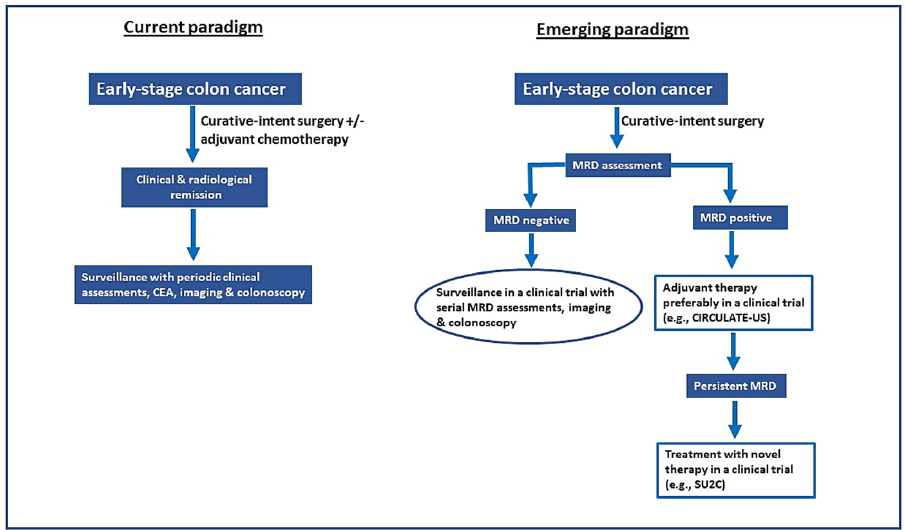
Figure 2. Comparison of current versus the evolving ctDNA-guided adjuvant therapy paradigm in patients with colorectal cancer treated with curative-intent surgery. However, the ctDNA-guided adjuvant therapy strategy needs confirmation through prospective clinical trials before wide adoption in routine clinical practice. CEA, carcinoembryonic antigen; MRD, minimal residual disease.